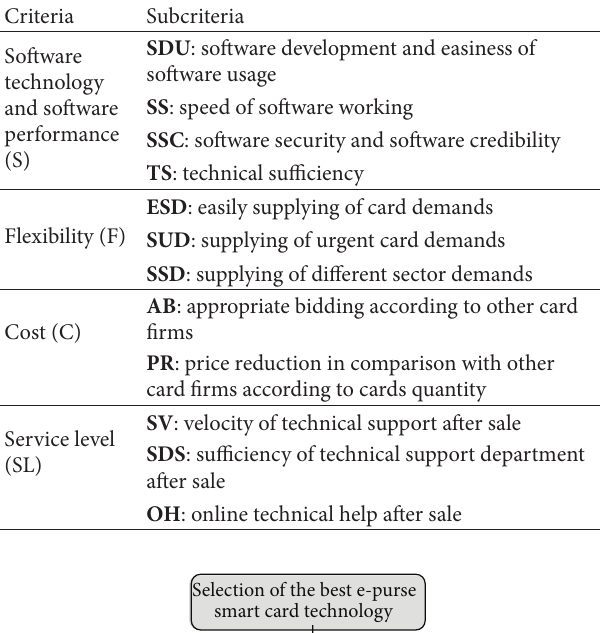
Table 1: Criteria and subcriteria for e-purse smart card technology selection.